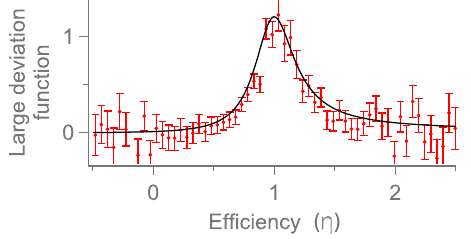
FIG. 5. Large deviation function for the efficiency J ð η Þ , defined in Eq. (23), for symmetric driving. Solid line is calculated using Eq. (25).